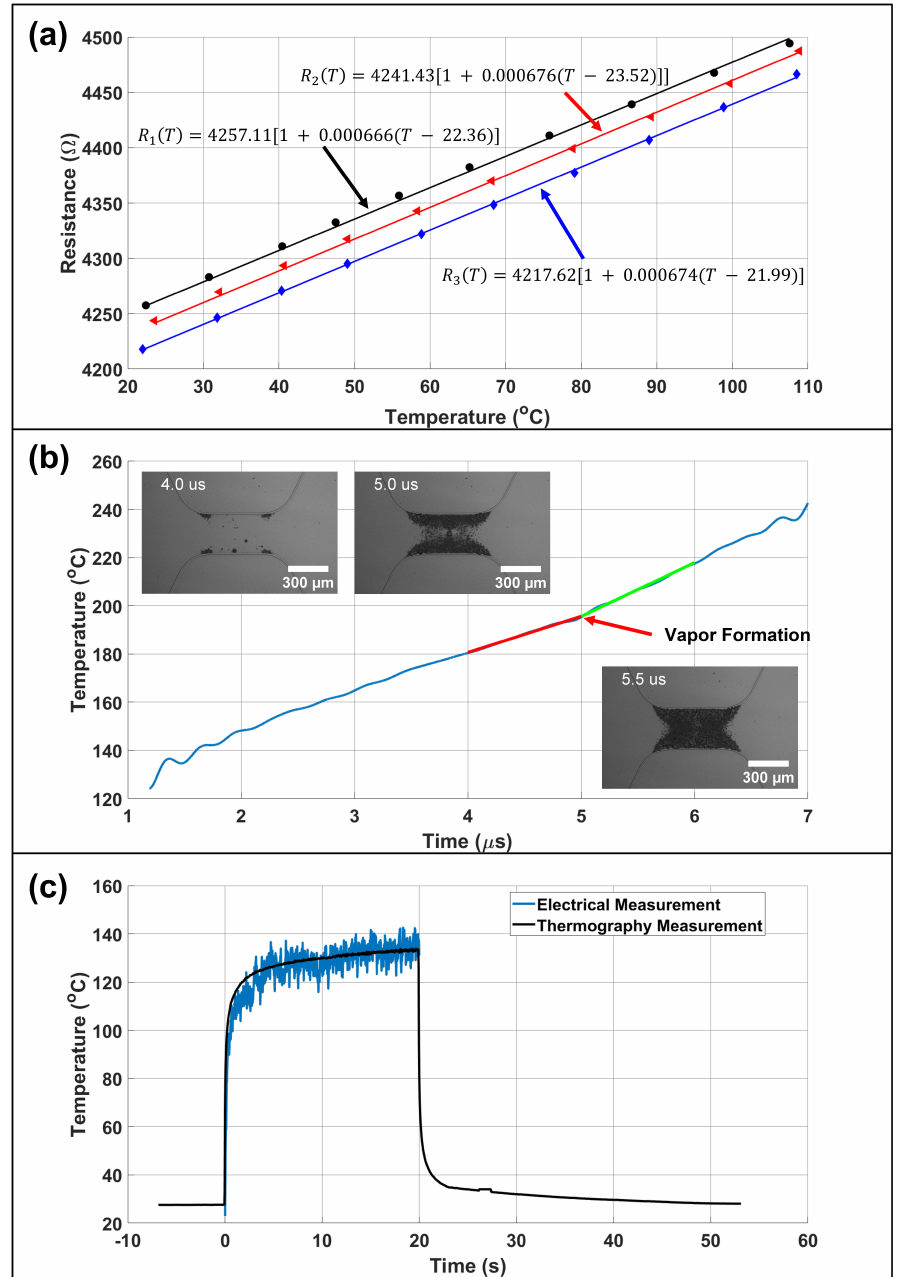
Figure 8. TMP Resistor Surface Temperature—shows the temperature coefficient of resistance (TCR) and surface temperature measurements. ( a ) illustrates TCR measurements for 3 resistors on separate FTO 8 Ω /sq substrates to determine inter-sample uniformity. The TCR value for FTO 8 Ω /sq substrates was 6.72 × 10 − 4 ± 5.37 × 10 − 6 [1/ ◦ C]. ( b ) depicts the surface temperature of an R = 48.32 Ω , 300 × 700 µ m 2 FTO TMP resistor during a 8 µ s, 100 V heating pulse. A low pass Butterworth filter of order 12 with a half power frequency of 3.33 MHz was used to remove signal noise. Oscilloscope data was recorded at 2 GHz, with N = 64 sample averaging. Insets show stroboscopic images at t = 4 µ s, the onset of bubble nucleation, t = 5 µ s, and t = 5.5 µ s, full vapor layer formation. Once the vapor layer forms, the heat transfer coefficient is significantly reduced resulting in a change of slope at approximately t = 5.0 µ s denoted by the highlighted tangent lines. ( c ) shows agreement between electrical and thermography measurements for the resistor surface temperature when fired in air with a 20 s, 6.5 V heating pulse. Electrical measurement data was filtered with a moving